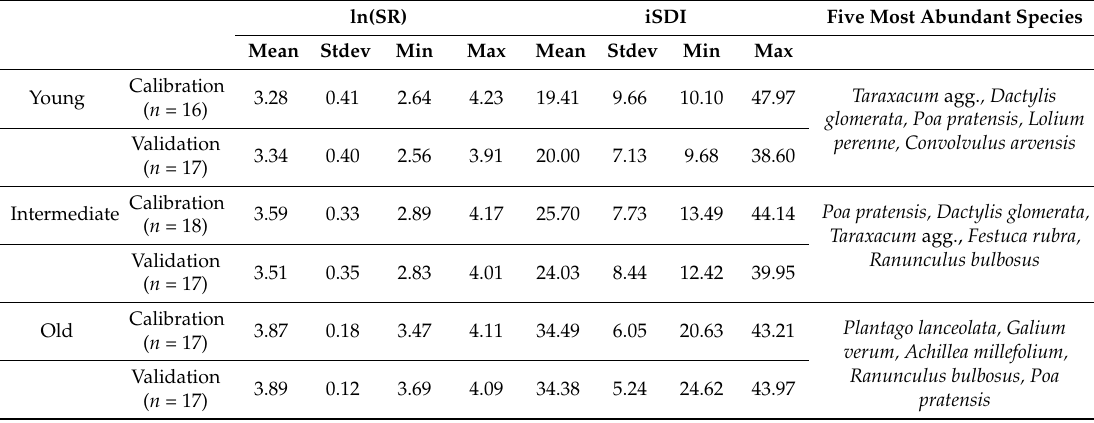
Table A3. Summary statistics for the ln-transformed species richness ln(SR) and the inverse Simpson’s diversity index (iSDI) values within the calibration and validation subsets for the 4 m ˆ 4 m plots within each of the three grassland age-classes (young, intermediate-aged and old grasslands). The five most abundant species recorded within each grassland age-class are also presented.